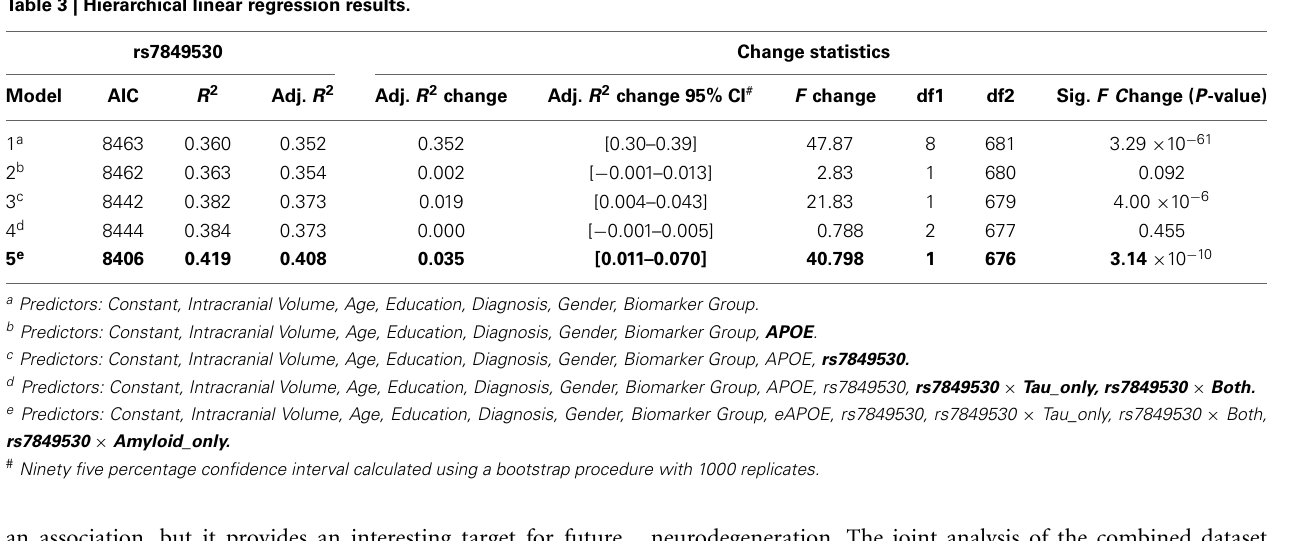
tau × rs7849530 interaction was statistically significant in both datasets ( p ≤ 0 . 001). In ADNI-1, tau positive homozygous carriers of the G allele showed a greater rate of ventricular dilation than tau positive carriers of the T allele ( p < 0 . 05), and the same trend was present in ADNI-2/GO ( p = 0 . 059).